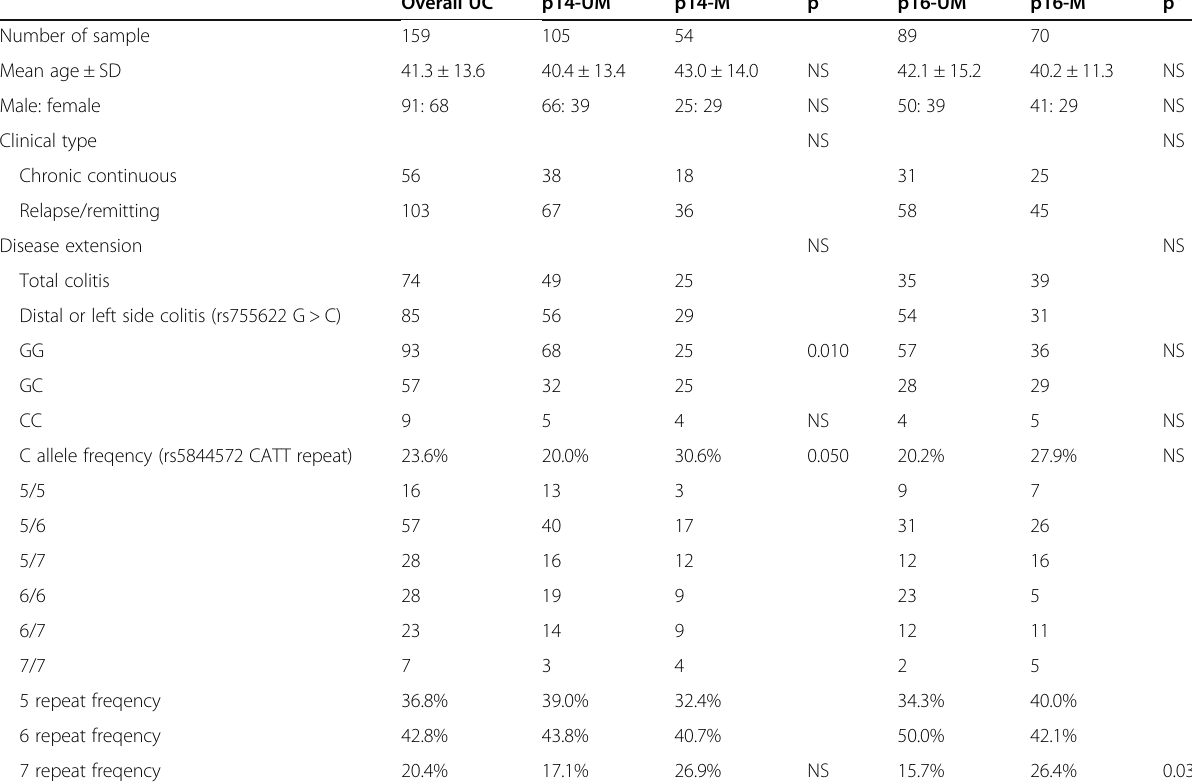
Table 2 Demographic characteristics, allelic frequencies, and CDKN2A methylation status